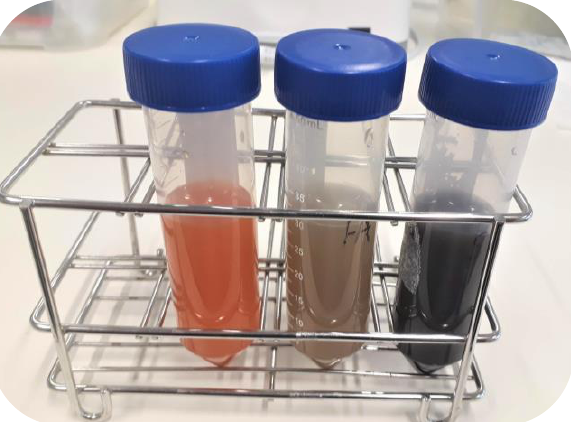
Figure 3. Suspension of GPC precursors resulting from 120 min of reaction time with 10 M sodium hydroxide solution. From left to right: MK, BFA, and EAFS.